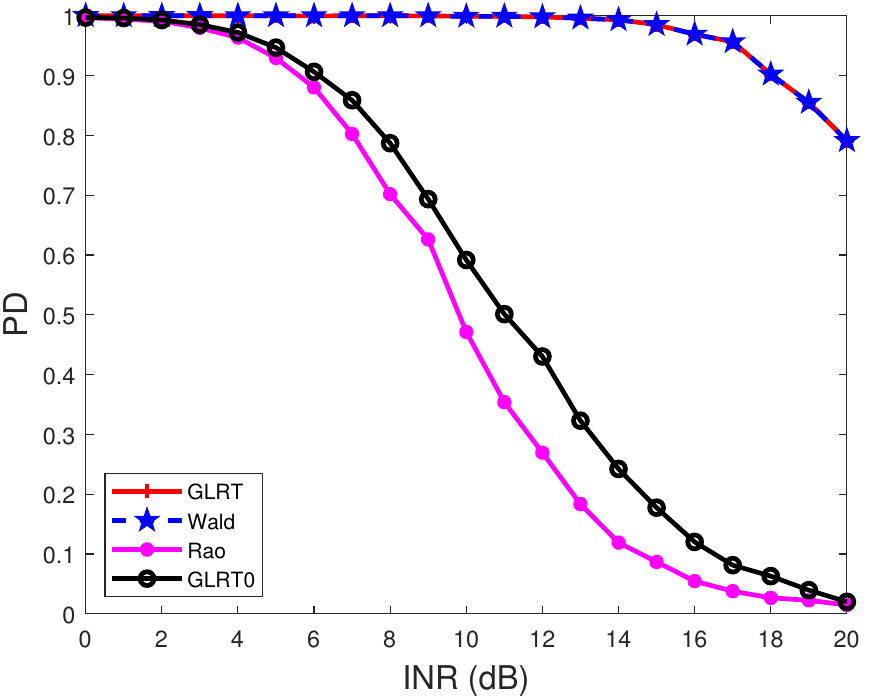
Figure 5. PDs of the detectors under different INRs. R ( i 1 , i 2 ) = 0.95 | i 1 − i 2 | , N = 8, p = 1, M = 2 N , θ t = 0.2, θ 1 = 0.25, θ 2 = 0.3, θ 3 = 0.4, and SNR = 15